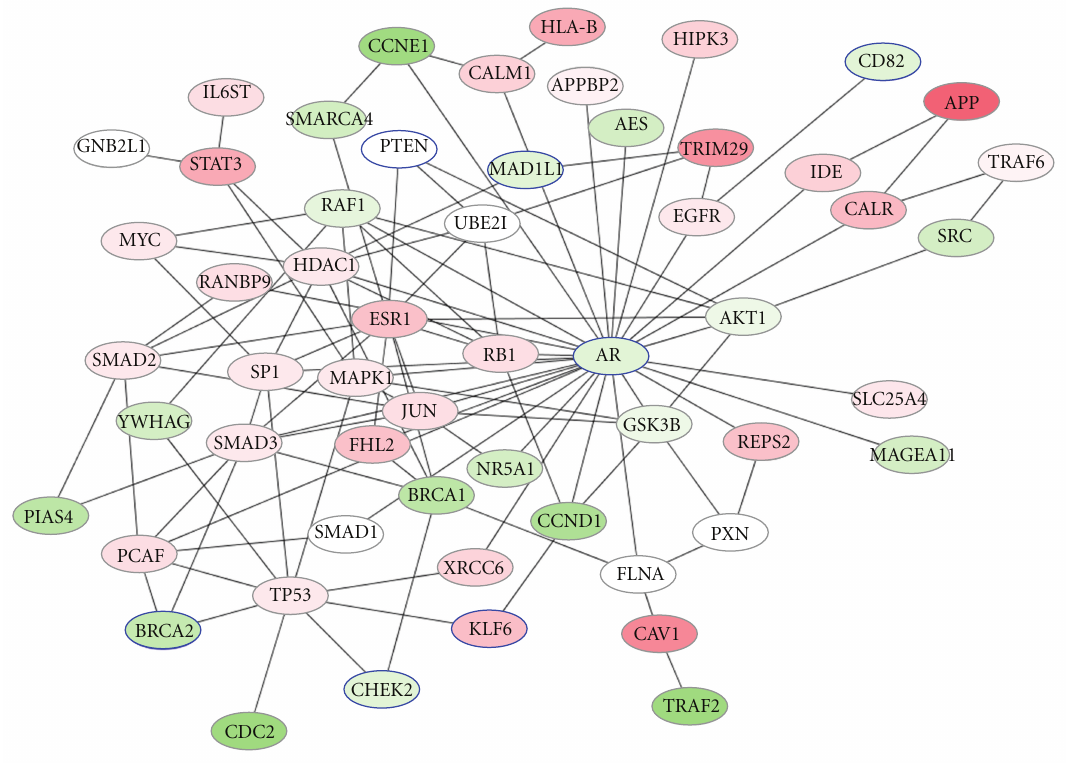
Figure 8: Prostate-metastatis experiment top 50 genes induced result network. Red color shows the higher di ff erence in expression between prostate cancer and lymph node metastasis tissue sample, on the other hand the green color shows the smaller di ff erence in expression between the samples. Nodes with node circle denote Seed